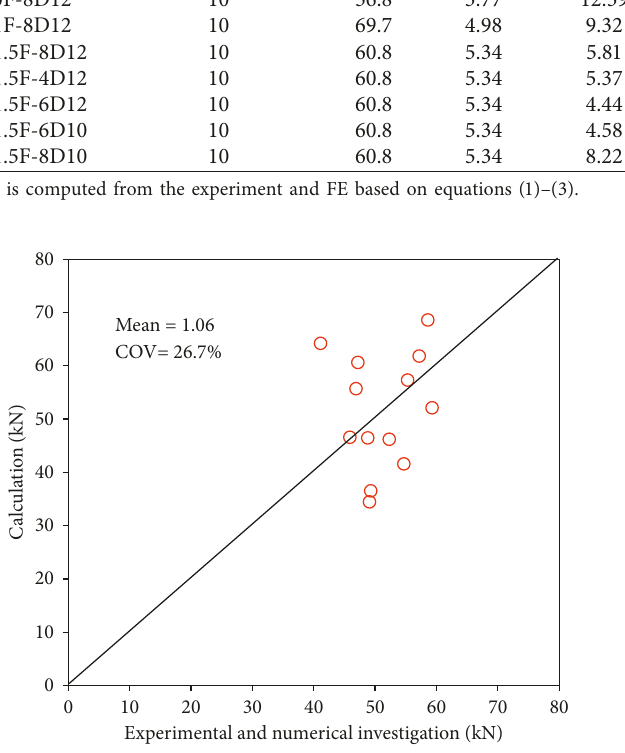
Figure 20: Comparison in shear contribution of SFRC panels between investigation and calculation using the developed